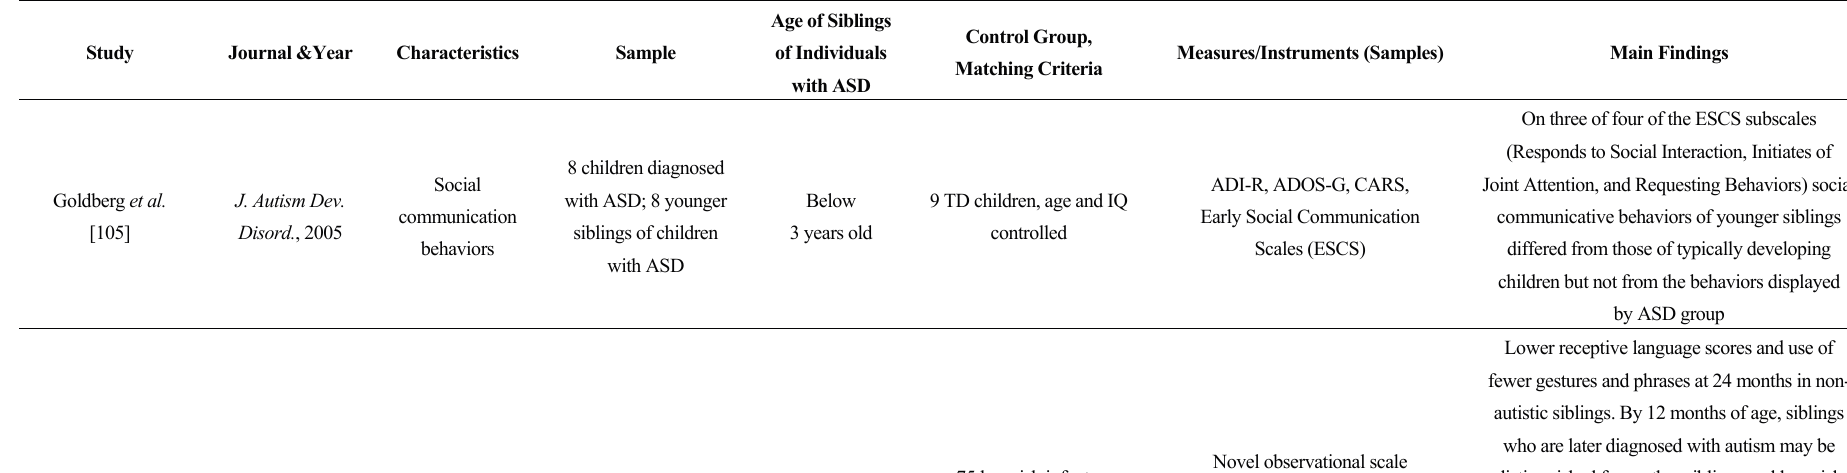
Table 2. Studies on infants and toddlers at risk for